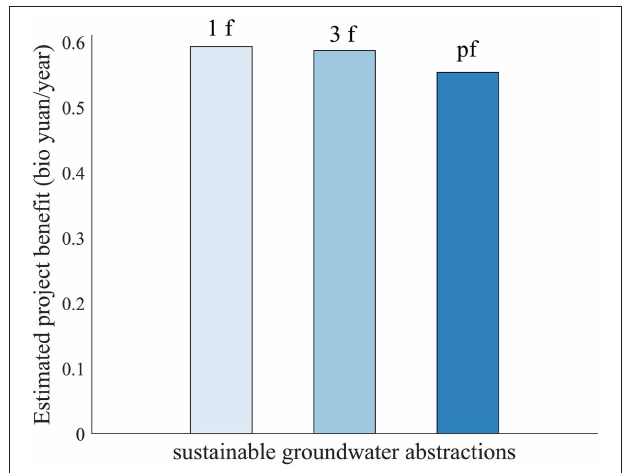
FIGURE 10 | Project benefits with 1f, 3f, and perfect foresight (pf) scenarios, all representing results in the sustainable groundwater abstraction scenario.